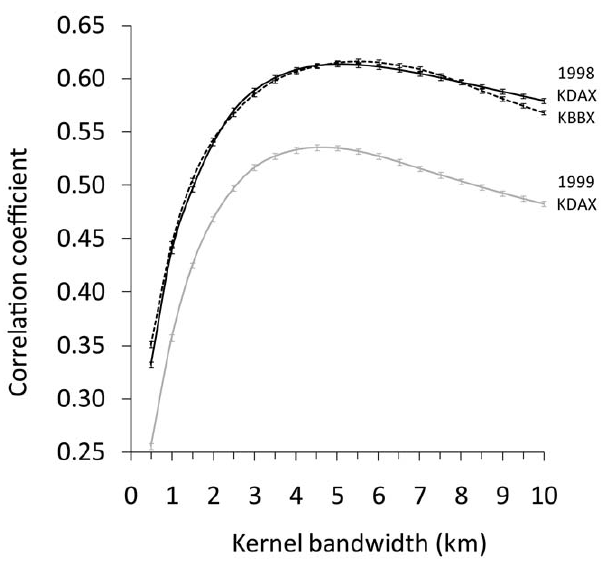
Figure 4. Correlations between radar and telemetry data. Mean correlation among 2 000 bootstrapped samples between the mean radar reflectivity (i.e., index of bird density) and the kernel density of radio-marked waterfowl locations estimated for different bandwidth sizes by winter and radar. Error bars denote 6 1 standard error.